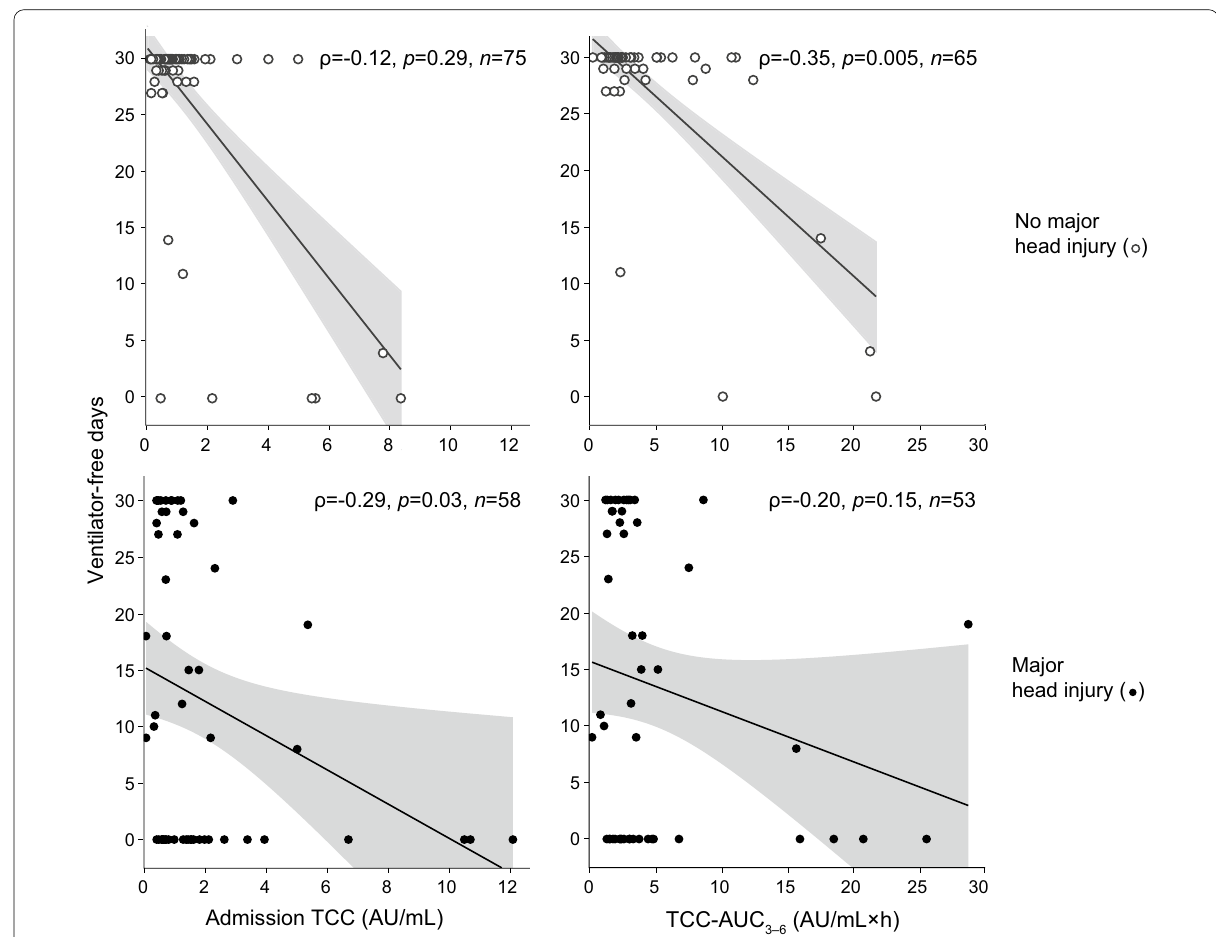
Fig. 4 Ventilator-free days. Terminal Complement Complex (TCC) vs. ventilator-free days (VFD) for patients without major head injury (open symbols) and with major head trauma (filled symbols). Admission TCC concentrations are shown in the two left panels and TCC-AUC 3–6 in the two right panels, with linear fit and 95% confidence interval for the fitted line (shaded). ρ , Spearman’s rank correlation